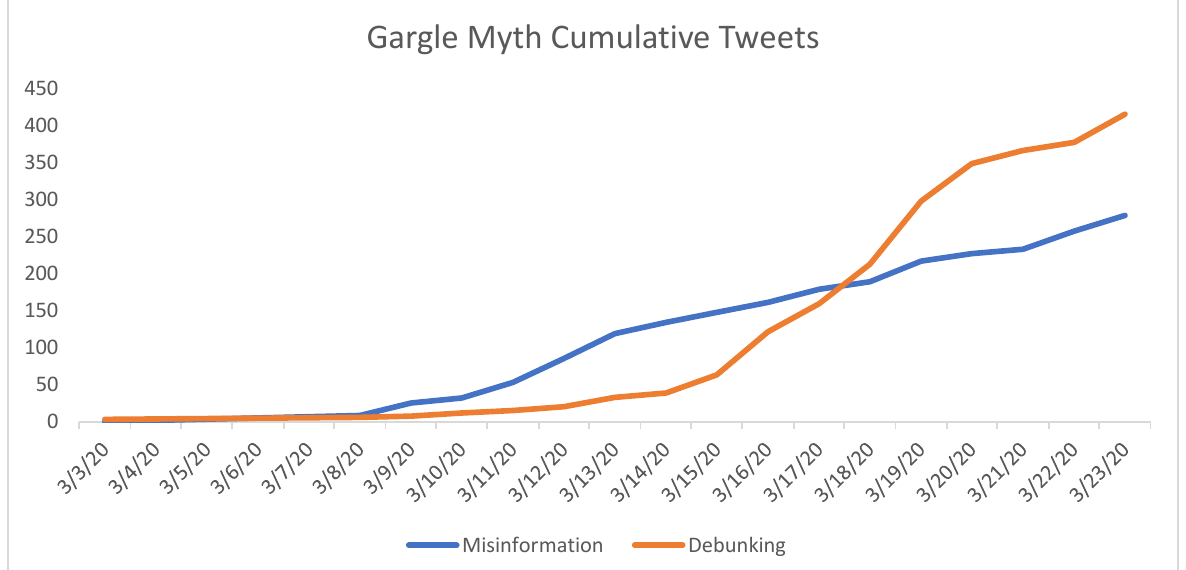
Figure 7. Gargle myth cumulative misinformation tweets vs. debunking tweets over